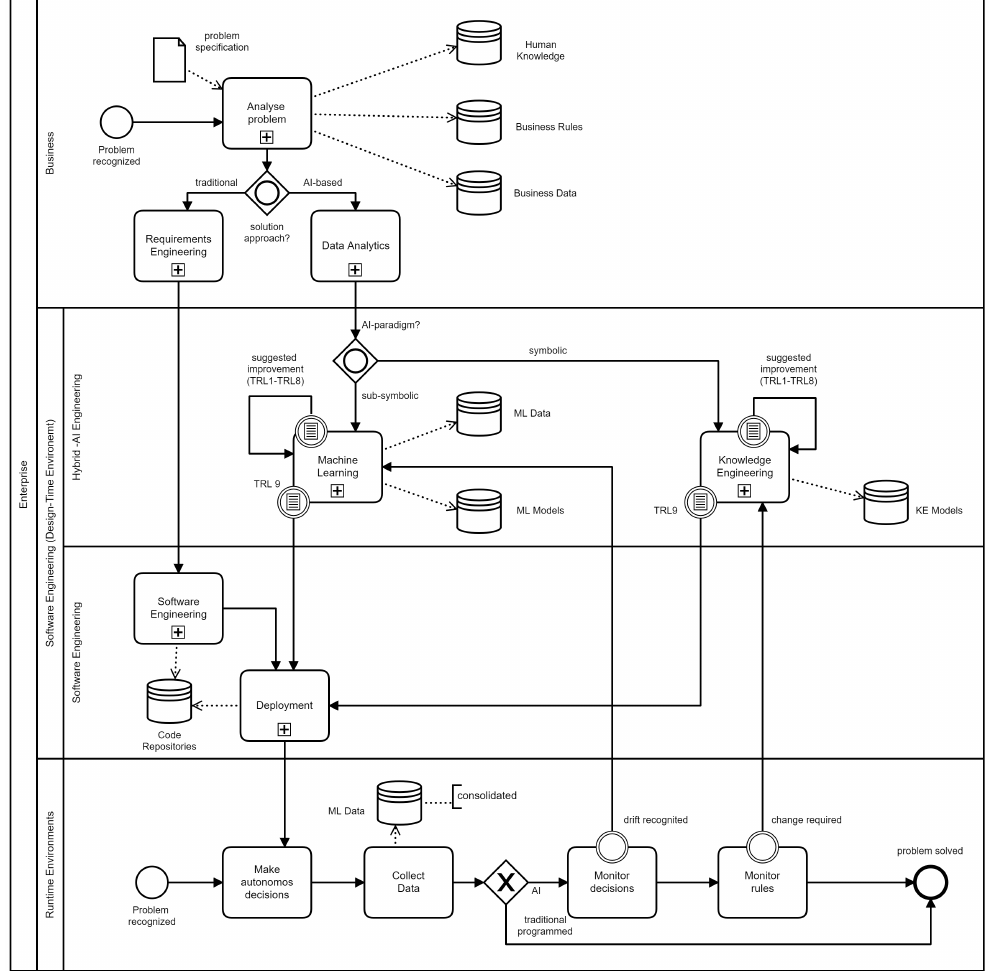
Figure 2. Embedding AI solutions into the